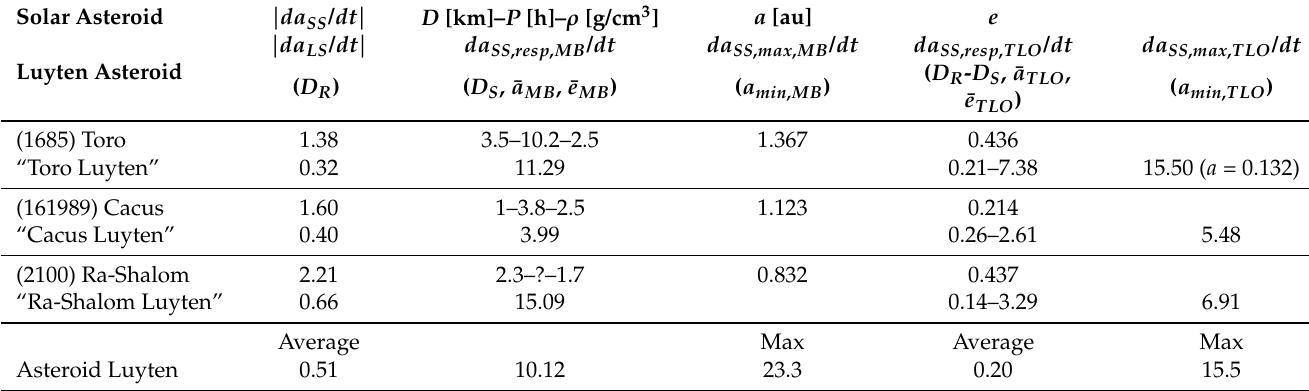
Table 5. D R is the real diameter equal to the diameter of a real asteroid in the solar system, and D S is the diameter of a small asteroid (100 m). The acronyms used in this table are: YD—Yarkovsky drift, LS—Luyten’s system, MB—main asteroid belt, TLO—Trans-Luyten-Objects, SS—solar system. The YD, da / dt , is in 10 − 4 au/Myr. For the detailed description of the table entries, see the main text. Column 1: the YD of the MB asteroids and the Luyten MB asteroids. Column 2: the diameter, period, and density of the asteroid in the MB and a Luyten asteroid with the diameter of 100 m. Column 3: the semi-major axis of the asteroid in the MB, the YD of the Luyten belt asteroid of 100 m in the Luyten belt. Column 4: the eccentricity of the MB asteroid and the YD of the Luyten asteroid in the outer region, and the YD of the 100-m Luyten asteroid. Column 5: the YD drift of the Luyten TNO.